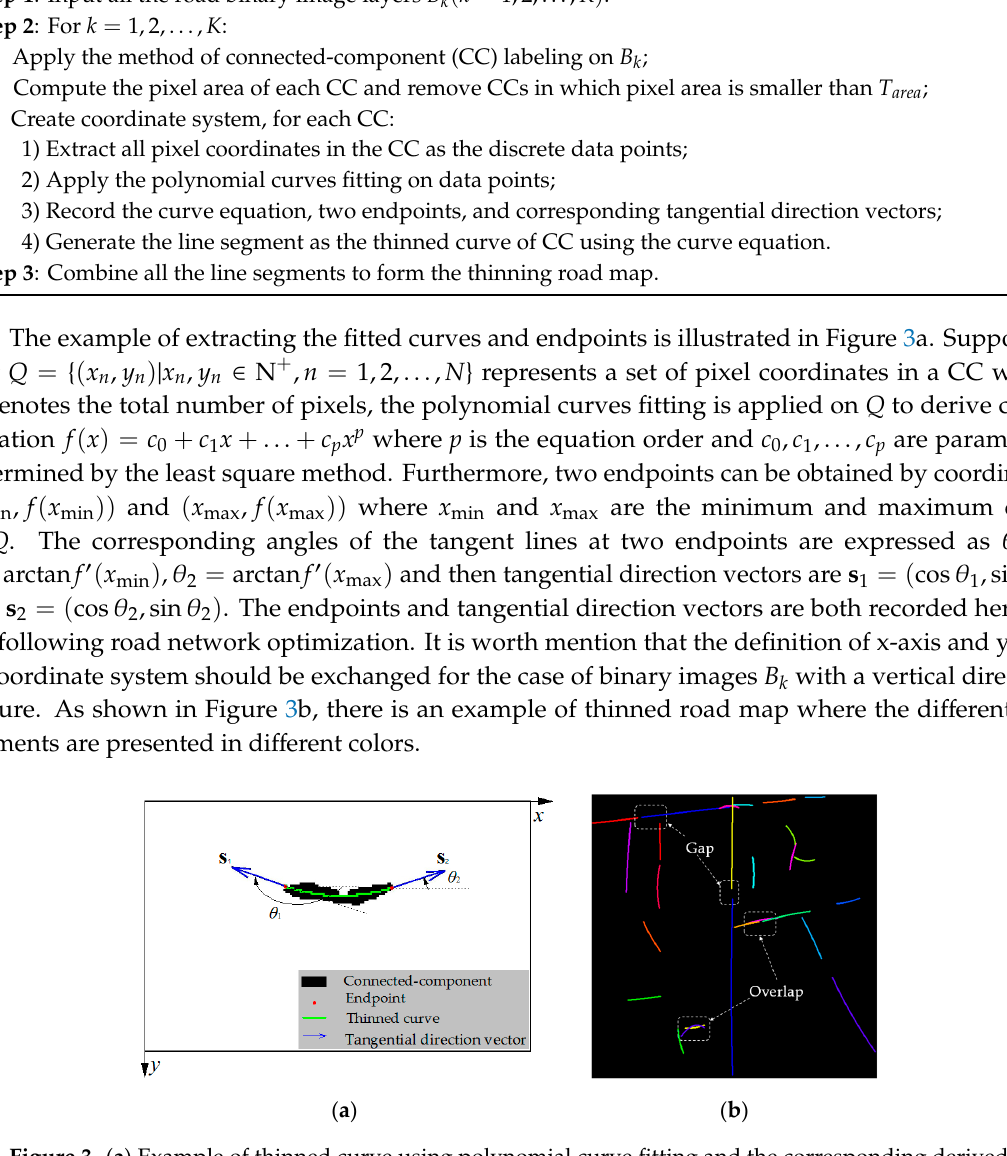
Figure 3. ( a ) Example of thinned curve using polynomial curve fitting and the corresponding derived endpoints and tangential direction vectors. ( b ) Example of thinning result using the proposed method (different line segments are marked with different colors; cases of overlap and gaps are pointed out).